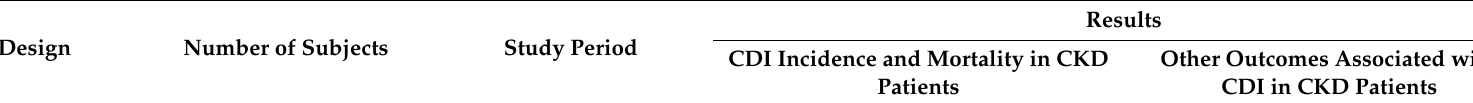
Table 1. Epidemiological studies analyzing incidence and characteristic of CDI in chronic CKD